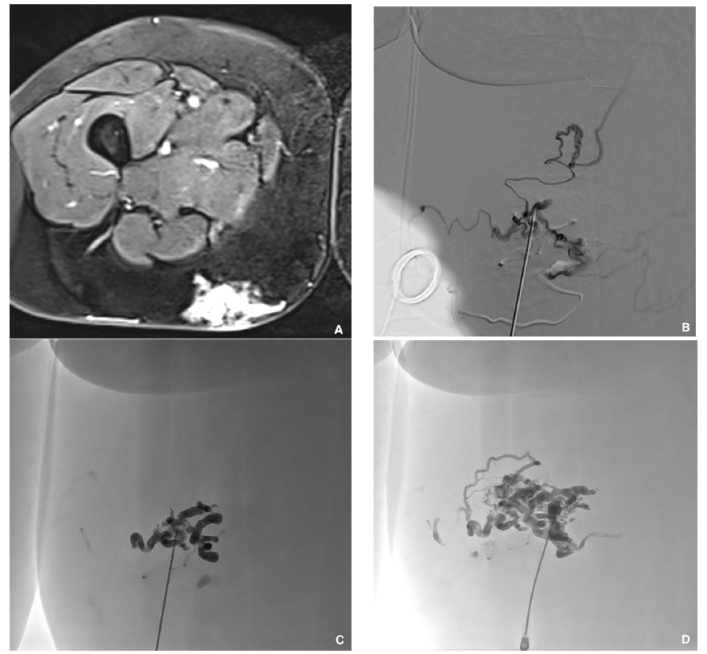
Figure 5. Superficial painful buttock arteriovenous malformation (AVM) in a 61-year-old patient . ( A ) Axial magnetic resonance imaging shows posterior subcutaneous contrast enhancement at the arterial phase, corresponding to the AVM. ( B ) Direct puncture of the nidus with a 21-gauge metallic needle and opacification of the nidus. ( C ) Embolization with a Glubran ® 2/Lipiodol ® mixture of a 1:5 ratio. ( D ) Final result after complete embolization of the nidus.